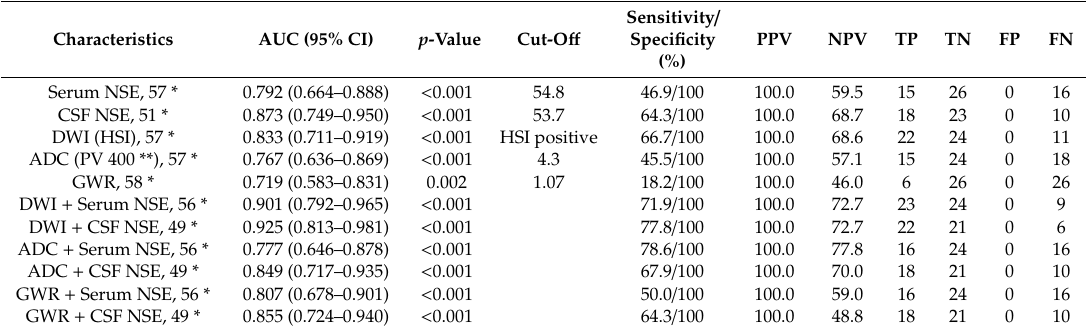
Table 3. Prognostic performances of levels of serum and CSF NSE, DWI, ADC, and GWR for predicting three-month poor neurological outcome.